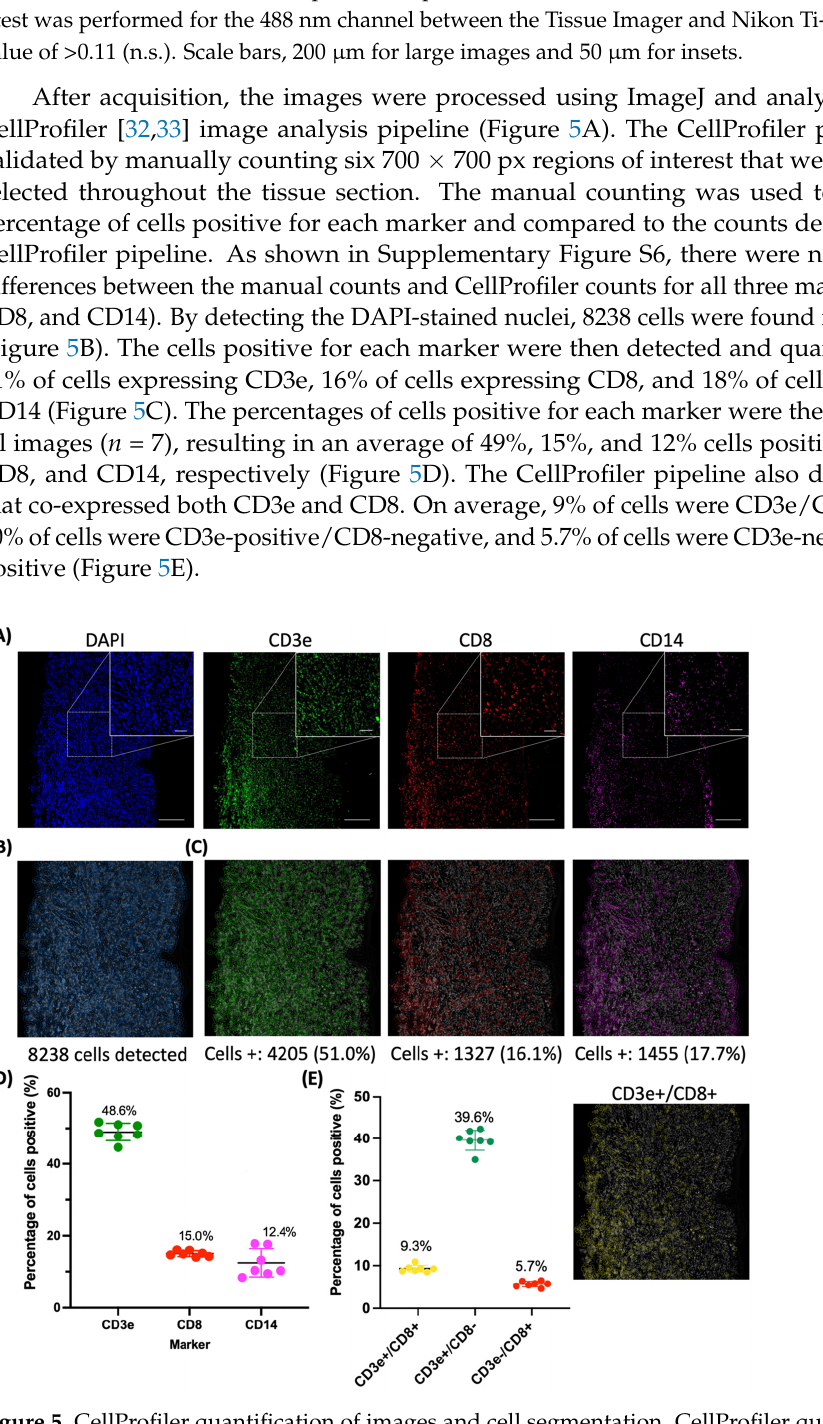
Figure 5. CellPro fi ler quanti fi cation of images and cell segmentation. CellPro fi ler quanti fi cation Figure 5. CellProfiler quantification of images and cell segmentation. CellProfiler quantification of of images and cell segmentation. ( A ) The fl uorescence images obtained from the Tissue Imager images and cell segmentation. ( A ) The fluorescence images obtained from the Tissue Imager (DAPI, CD3e, CD8, CD14). ( B ) The cell segmentation outline from the CellPro fi ler pipeline. ( C ) Cells identi fi ed as positive for the staining for each marker were outlined and the cells-positive percent- ages were calculated ( n = 7). ( D ) Percentage of cells positive for each marker with the average of 49%, 15%, and 12% for CD3e, CD8, and CD14, respectively. ( E ) Percentage of cells CD3e+/CD8+, CD3e+/CD8 − , CD3e − /CD8+ were, on average, 9.3%, 40%, and 5.7%, respectively. Outline of cells CD3e+/CD8+. Sca tt er plots were plo tt ed with the mean and standard deviation.